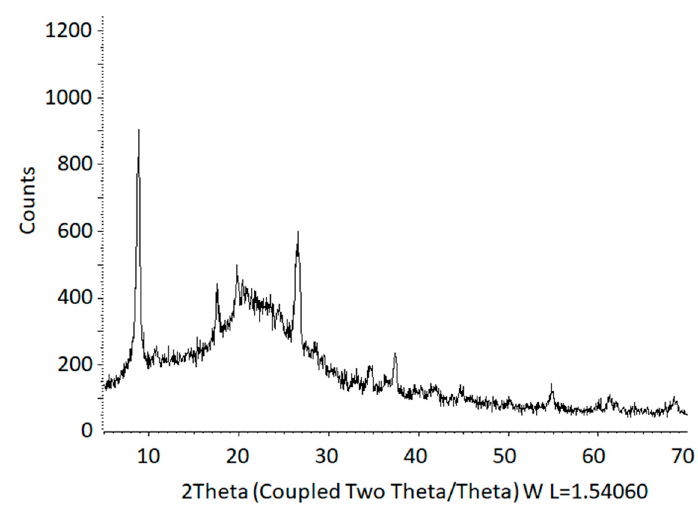
Figure 9. XRD pattern of the recovered H-FH after the catalytic reaction.